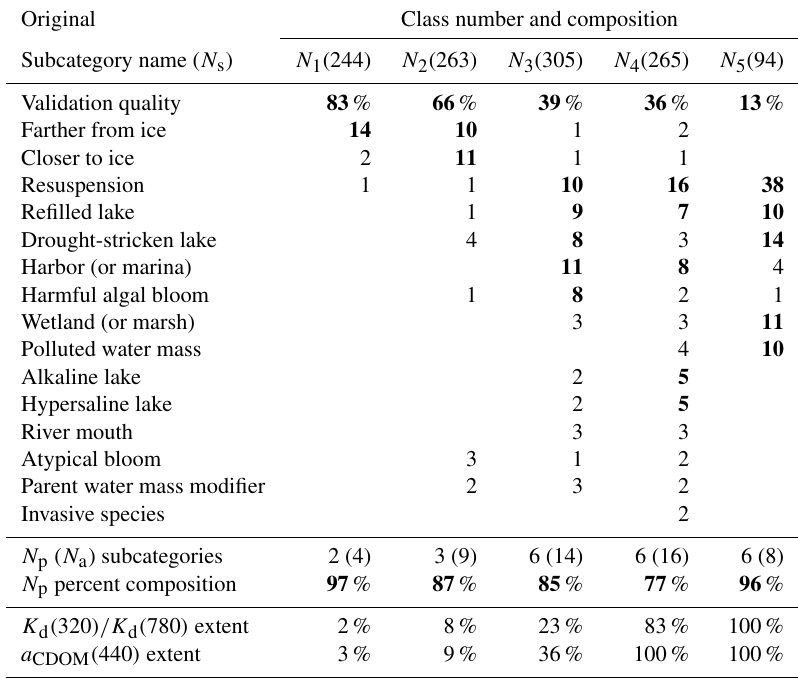
Table 2. The objective FCM classification of the data in Figs. 3–8 with a few omissions to ensure consistent data quality (e.g., White Lake, Bear Lake, ship-induced resuspension). The five classes N i , where i is the class number index, are shown with the number of K d (λ) spectra, N s , within each class in parentheses, as well as the percent composition of the original 16 subjective subcategories equalling or exceeding a 1% contribution threshold for each class. The principal subcategories in each class, i.e., the most numerous (approximately 5% contribution or more), are shown in bold. Below the subcategories, the number of principal subcategories ( N p ) and the number of all subcategories ( N a ) with a 1% composition or more are summarized in slanted typeface followed by the percent composition from all the principal subcategories. The extent of the dynamic range in percent for the optical and biogeochemical data is shown in the last two lines as a function of applying successive class